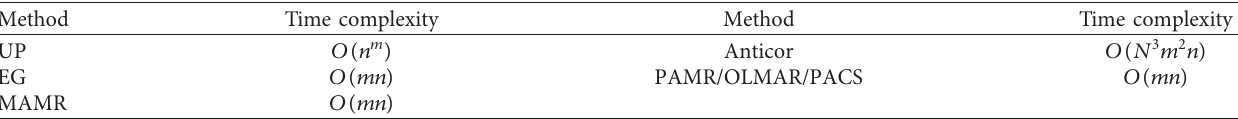
A LGORITHM 3: Portfolio selection with MAMR. Table 1: Summary of time complexity analysis.